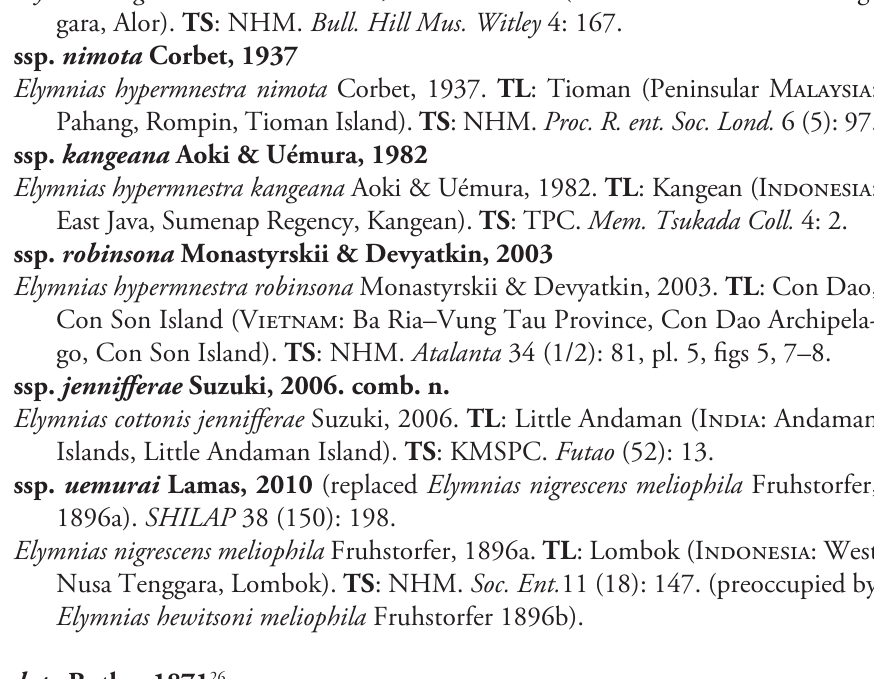
Specimen: Fig. 8K; Distribution: Fig.